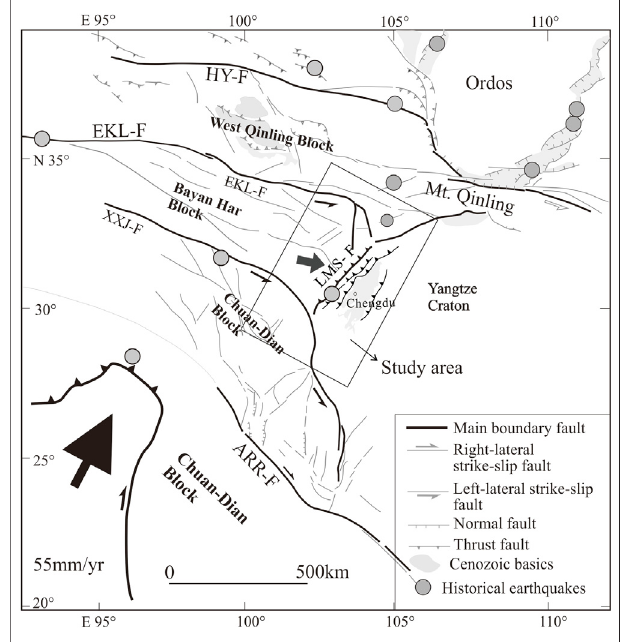
FIGURE 1 | Regional tectonic map of the eastern Tibetan Plateau. EKL-F, eastkunlunfault;HY-F,Haiyuanfault;QC-F,qingchuanfault;LMS-F,longmenshan fault; XXJ-F, Xianshuihe-Xiaojiang Fault; ARR-F, Ailao shan Red river